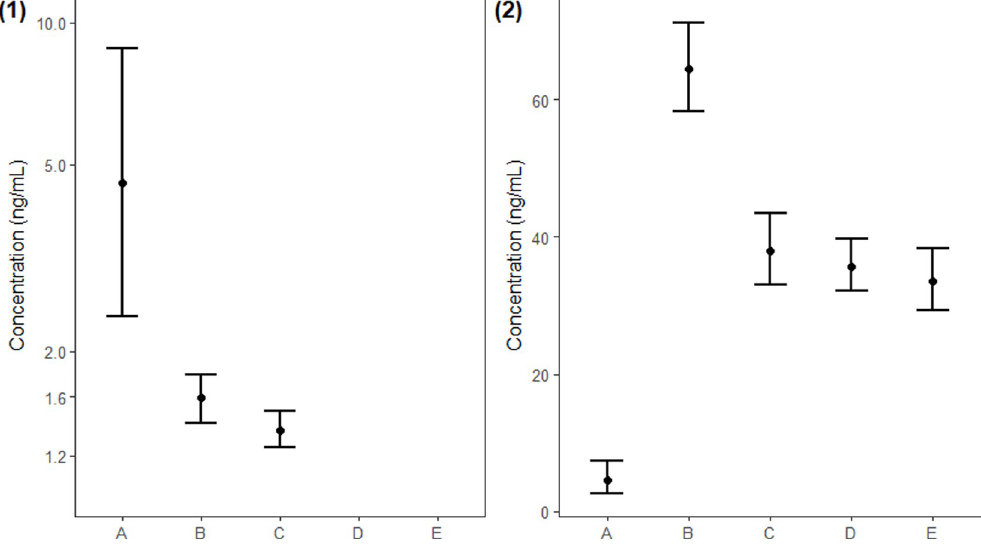
Fig 1. Geometric mean concentrations and 95% confidence intervals for detectable phthalate metabolites for Sarasota Bay bottlenose dolphins (“A”) and NHANES human reference populations (“B-E”: 1) MEHP (n = 28); 2) MEP (n = 15). Bottlenose Dolphin (A); NHANES 2009–2010 (B); NHANES 2011–2012 (C); NHANES 2013–2014 (D); NHANES 2015– 2016 (E).